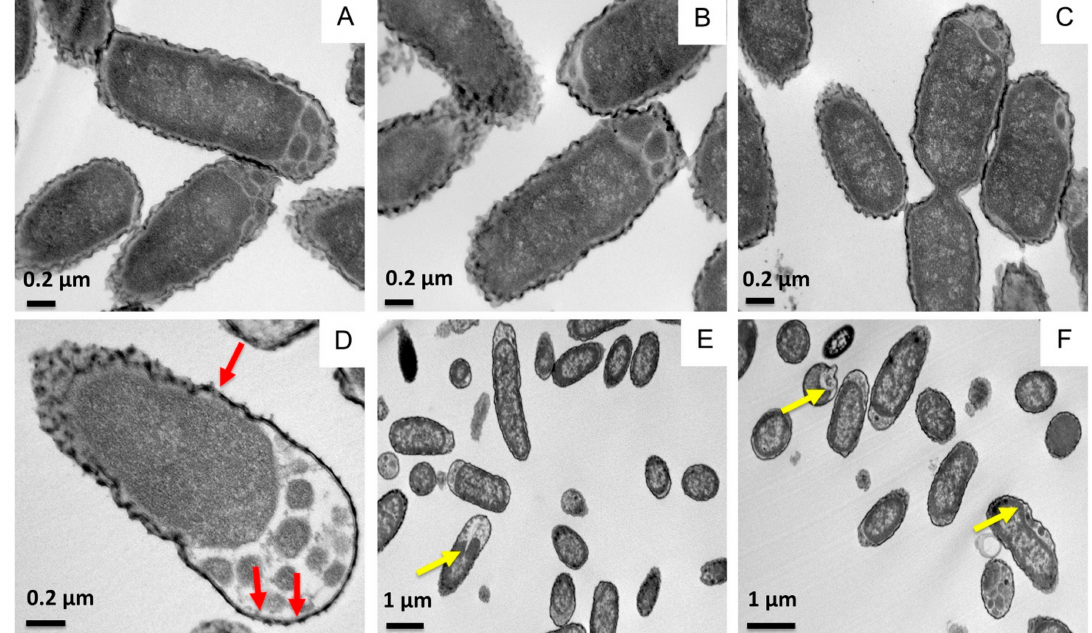
Figure 3. Effect of SP-A and/or SP-B N on the ultrastructure and morphology of K. pneumoniae K2. Untreated bacteria ( A ), and bacteria treated with SP-A (100 µ g/mL) ( B ), SP-B N (10 µ g/mL) ( C ), or SP-A+SP-B N ( D – F ). Red arrows indicate pores in the bacterial outer membrane, while yellow arrows indicate protrusions in the cytoplasmic membrane. One representative experiment of three is shown. Table 1. Bacterial length of untreated K. pneumoniae K2 and treated with SP-A 154 nM (100 µ